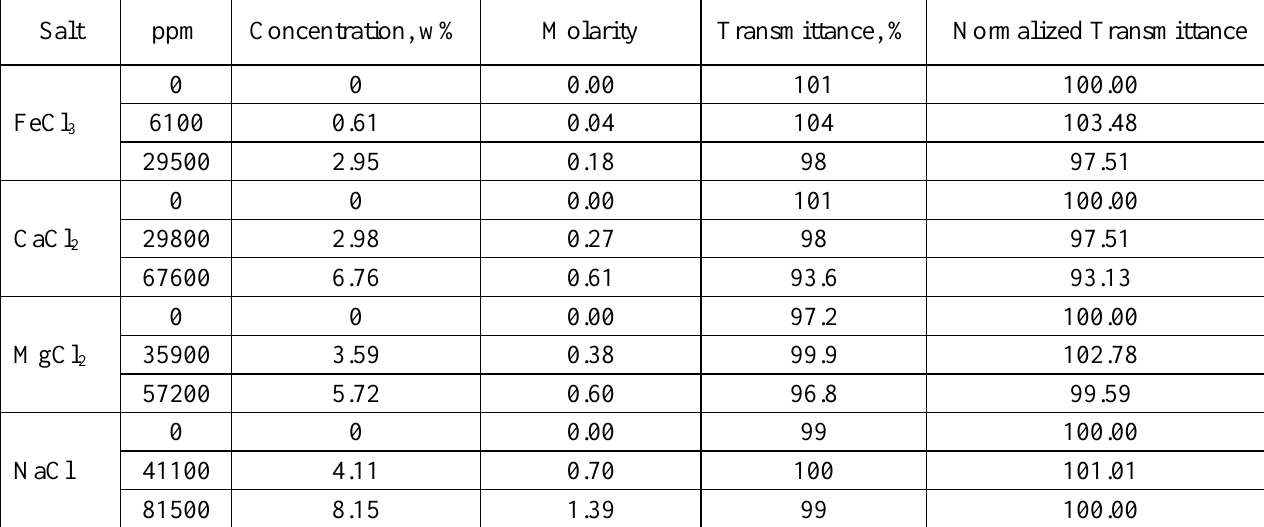
Table 5—Transmittance results of the less-damaging FR solution with different